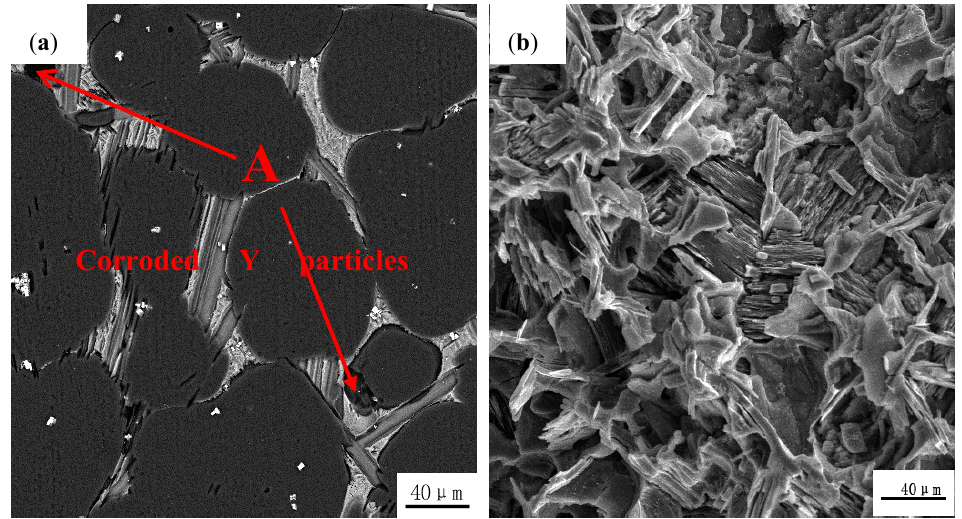
Figure 8. Corrosion morphologies of pre-extrusion heat-treated Mg 95.33 Zn 2 Y 2.67 alloy after removing the corrosion products for 1 h ( a ) and 98 h ( b ) immersion.